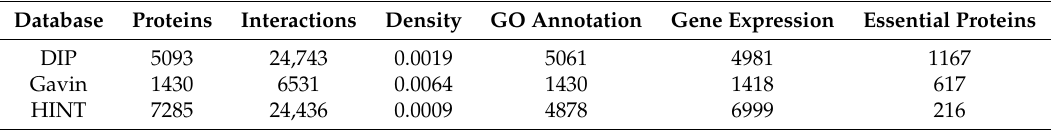
Table 1. The detail information of the experimental